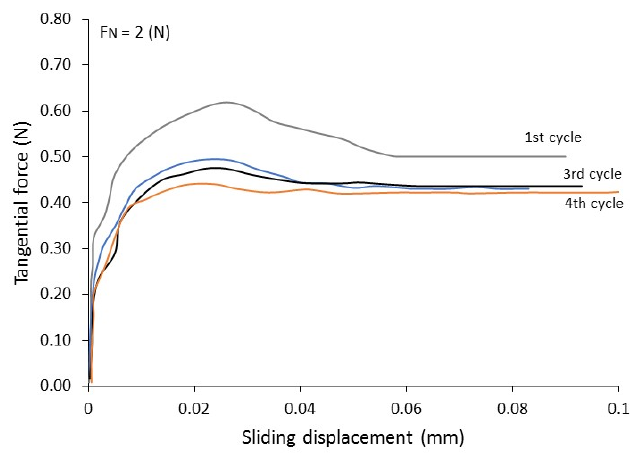
Figure 14. Tangential force–displacement plots at the contacts of LBS grains indicating the effect of the shearing cycle at a normal force of 2 N.